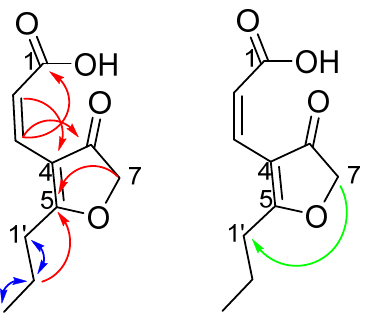
Figure 3. Selected HMBC (red) and COSY correlations (blue) and the long-range 5 J HH COSY correlation (green) for (2 Z )-cillifuranone ( 1 ).